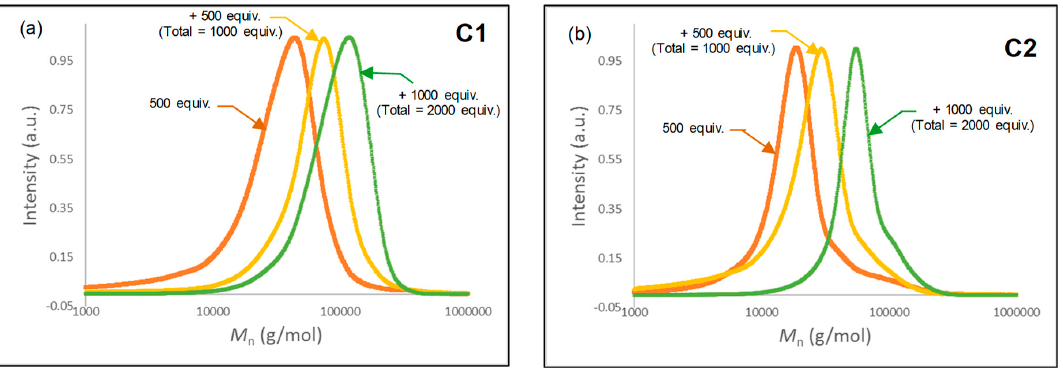
Figure 6. SEC traces of sequential polymerization using pre-catalysts (a, left) C1 and (b, right) C2 .